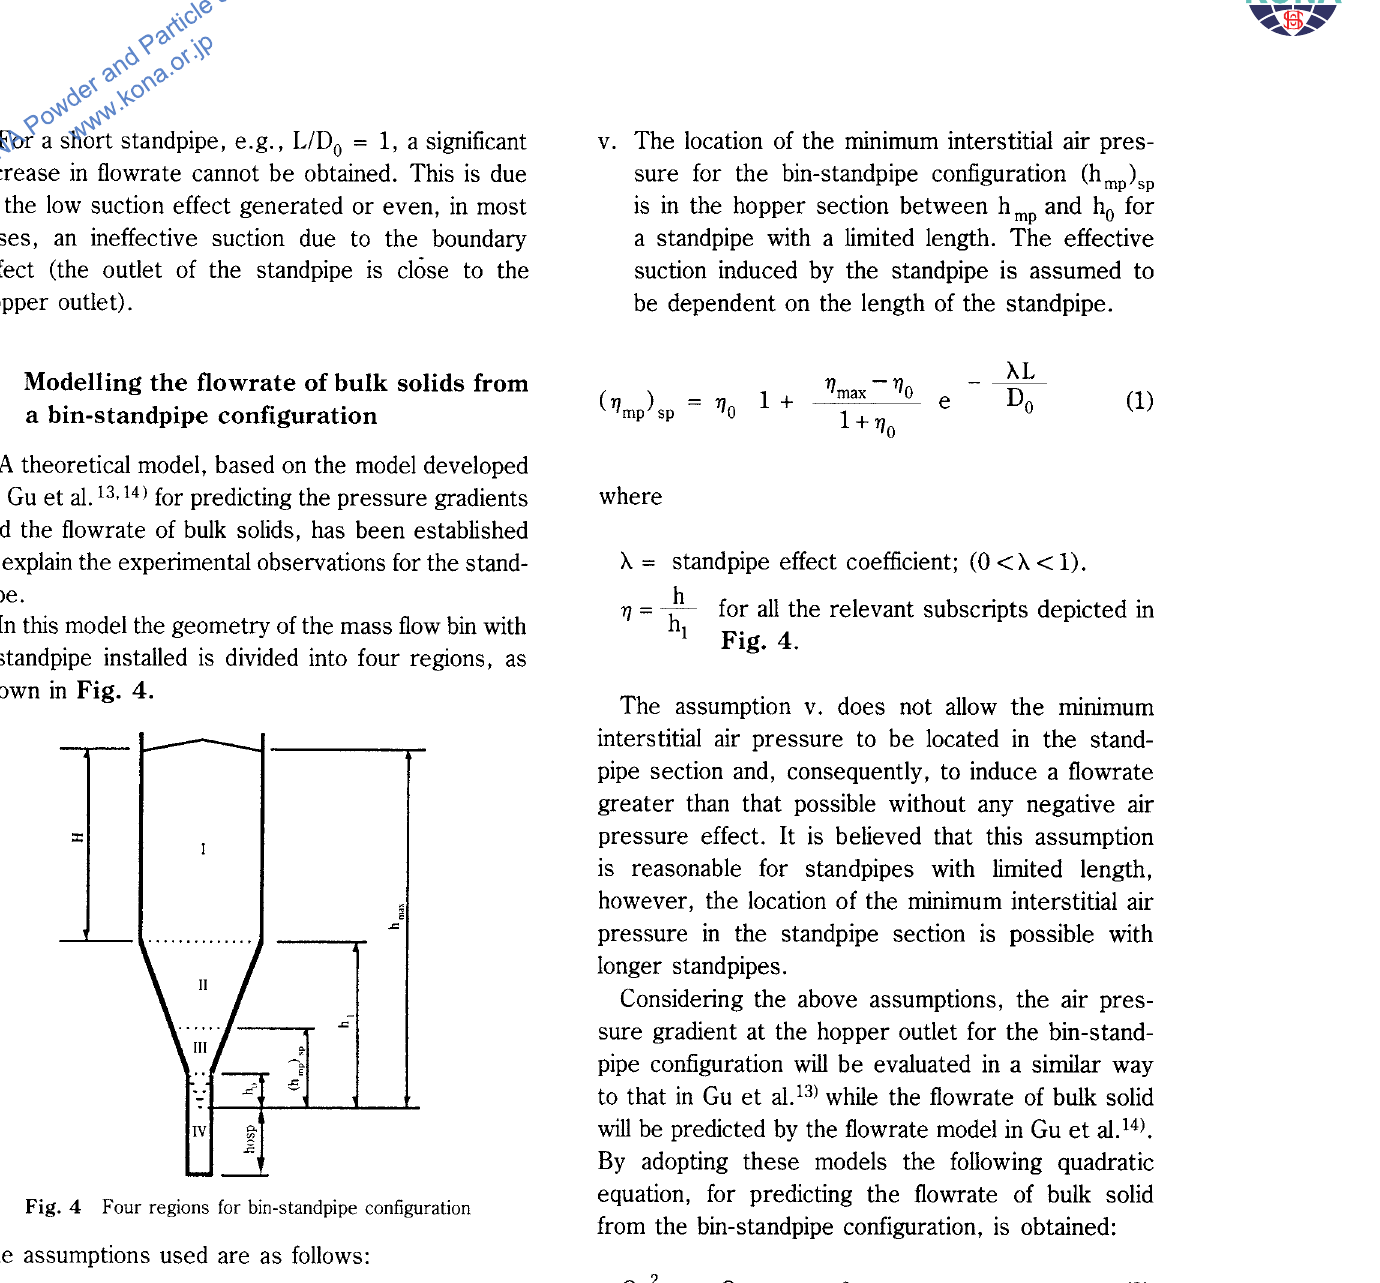
Fig. 4 Four regions for bin-standpipe